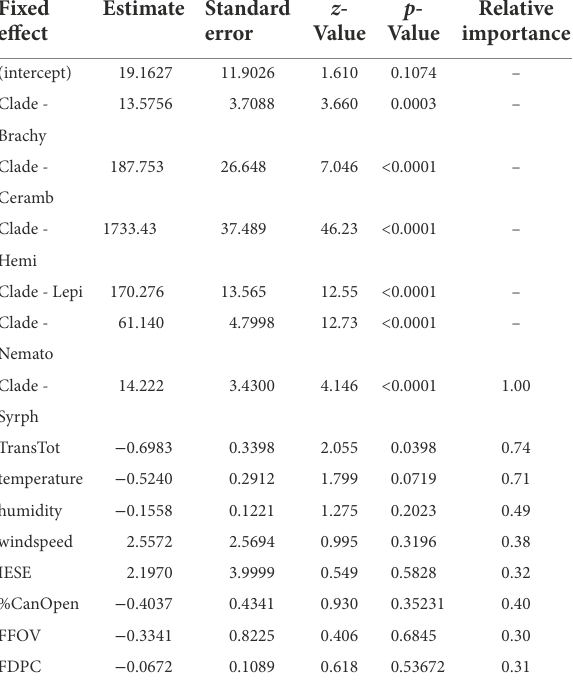
TABLE 3 Model-averaged values for predictors of handling time. FFOV=Flowers in the camera field of view; FDPC=Flower density per sampling grid cell; IESE = presence (1/0) of erroneous spike in temperature.